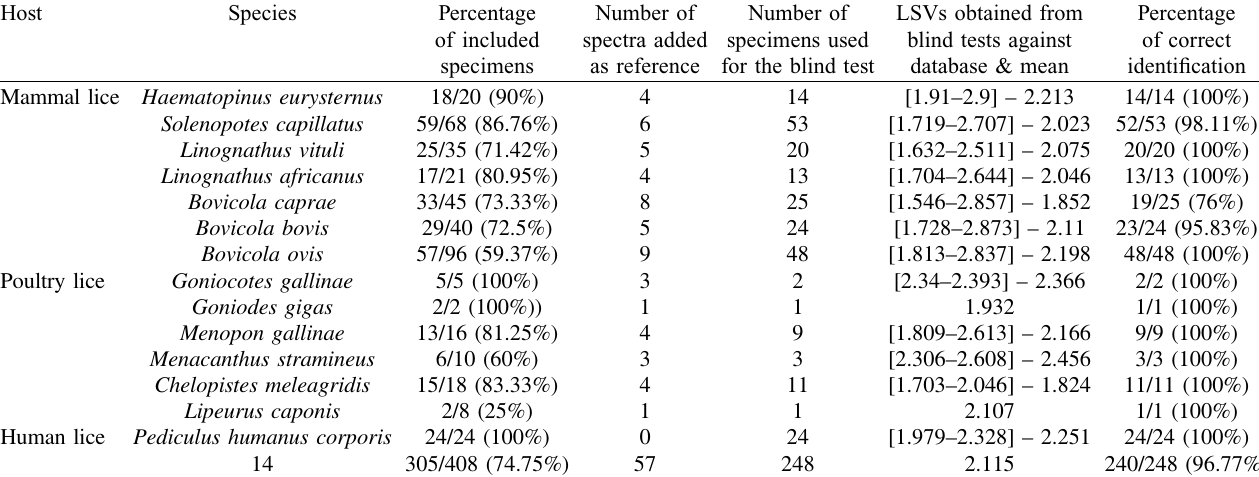
Table 4. MALDI-TOF MS identi fi cation of included louse species. Specimens were included based on the quality of their spectra (intensity, overall spectrum quality, and intra-species